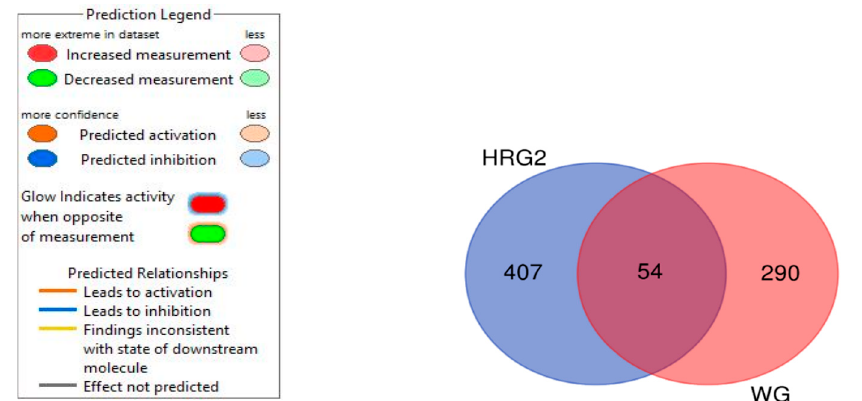
Figure 7. Molecular network shows predicted inhibition of abdominal neoplasm by: ( a ) HRG80 TM at a concentration of 1 μ g/mL and ( b ) WG at a concentration of 10 μ g/mL. Solid red or green color nodes indicate upregulated and downregulated genes, respectively; color intensity indicates the actual log-fold changes. The tags labeled with purple display the canonical pathways related to particular genes of the network. The tags labeled with khaki show various types of tumors associated with the molecules in subnetworks. ( c ) Venn diagram showing the number of product-specific and commonly deregulated (54) genes.